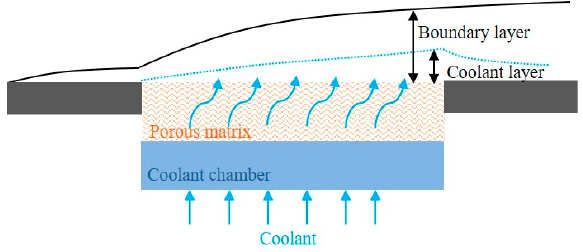
Figure 5. Schematic diagram of transpiration cooling.